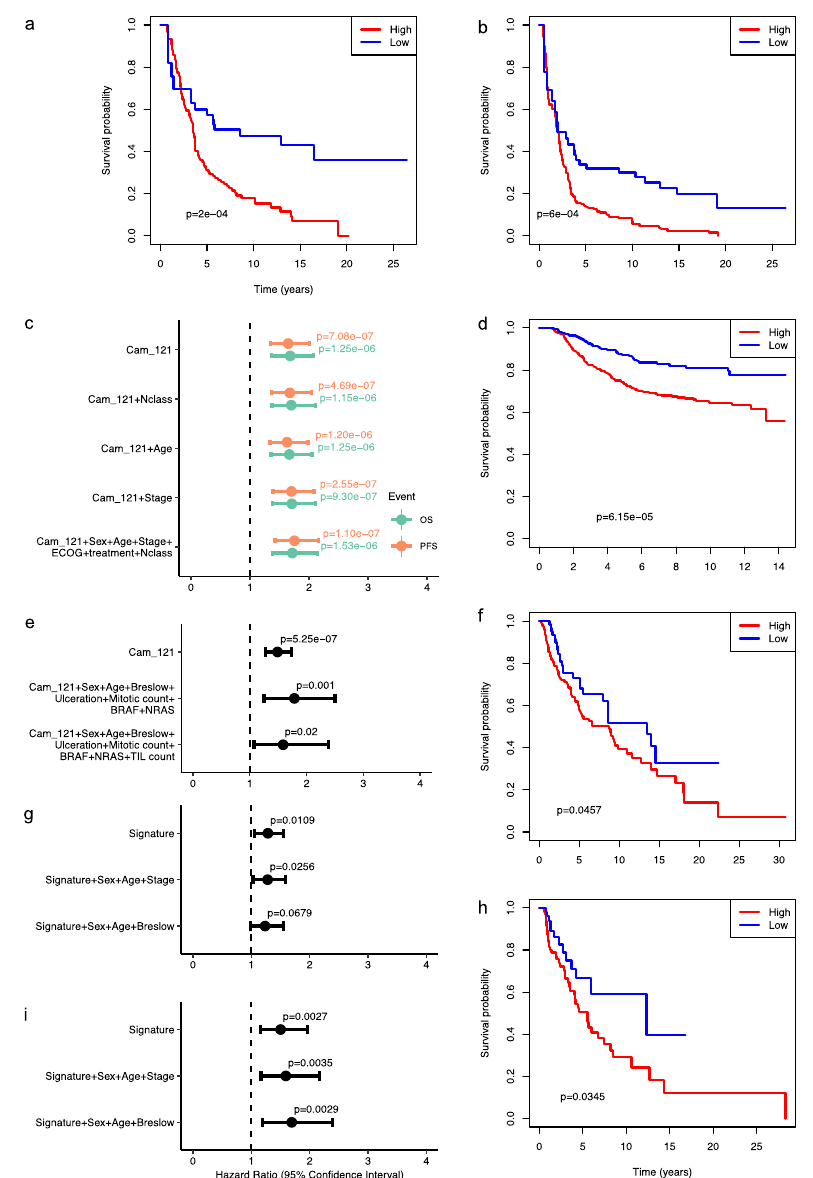
Fig. 2 Validation of the Cam_121 in further datasets. We explored the Cam_121 signature in the entirely separate lymph node (LN) samples from the AVAST-M Cohort ( a – c ; n = 143), as well as in three independently acquired external datasets including the Leeds Melanoma Cohort ( d , e ; n = 677), TCGA-SKCM LN ( f , g ; n = 212) and TCGA-SKCM Skin ( h , i ; n = 156). AVAST-M LN Cohort: Kaplan – Meier (K – M) survival plots comparing the survival probabilities ( y -axes) as a function of time in years ( x -axes) of groups with high and low “ Cam_121 ” (quantile 0.33 split) for outcomes a overall survival (OS) and b progression-free survival (PFS). The p value of a logrank test comparing the survival distributions of both groups is indicated on each curve. c Forest plot indicating the hazard ratio (HR) estimates (dots at the centre of the error bars) and corresponding 95% con fi dence intervals (horizontal error bars) related to the Cam_121 signature when predicting OS (green) and PFS (orange) by means of Cox proportional hazard models when controlling for different (sets of) clinical variables ( y -axis). The two-sided Wald t test p values corresponding to the signature “ Cam_121 ” parameter are indicated for each model and outcome. ECOG Eastern Cooperative Oncology Group Performance Status. Leeds Melanoma Cohort: d K – M curve comparing the melanoma- speci fi c survival probabilities ( y -axis) of groups with high and low “ Cam_121 ” (quantile 0.33 split) through time in years ( x -axis) and p value of a two-sided logrank test comparing the survival distributions. e Forest plot showing the HR estimates (dots at the centre of the error bars) and 95% con fi dence intervals (horizontal error bars) of the HR estimates corresponding to the continuous signature “ Cam_121 ” parameter when predicting melanoma-speci fi c survival by means of different Cox proportional hazard models ( y -axis). Multivariate correction was undertaken for sex, age, Breslow thickness, ulceration, mitotic count, as well as BRAF and NRAS mutation status and (in the fi nal row), correction was also undertaken for the tumour-in fi ltrating lymphocyte (TIL) score. TCGA-SKCM Cohort: f , h K – M curves comparing the overall survival probabilities of groups with high and low “ Cam_121 ” (quantile 0.33 split) and p value of a two-sided logrank test comparing the survival distributions in TCGA-SKCM LN and TCGA-SKCM Skin datasets, respectively. TCGA-SKCM Cohort: g , i Forest plot showing the HR estimates (dots at the centre of the error bars) and 95% con fi dence intervals (horizontal error bars) corresponding to the of related to the continuous signature “ Cam_121 ” parameter when controlling for different (sets of) clinical variables ( y -axes) in the TCGA-SKCM LN and TCGA-SKCM Skin datasets, respectively. Multivariate correction was undertaken for sex, age, stage and Breslow thickness. The p values of two-sided Wald t tests corresponding to the signature “ Cam_121 ” parameter are indicated for each model and outcome (no multiplicity correction